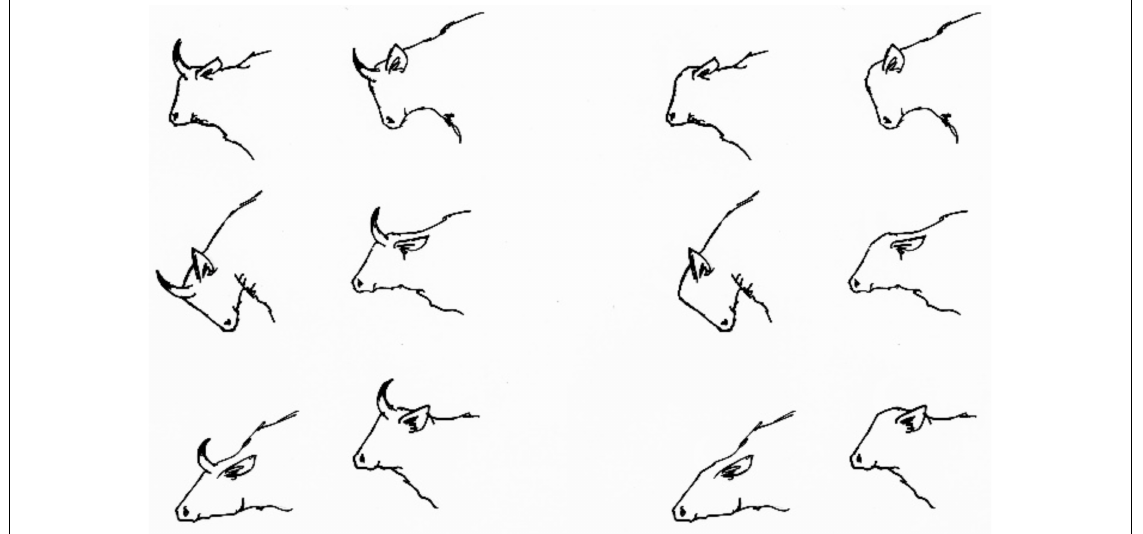
Figure 2. Horns emphasize visual display in cows. Adapted from [43], original courtesy of J.